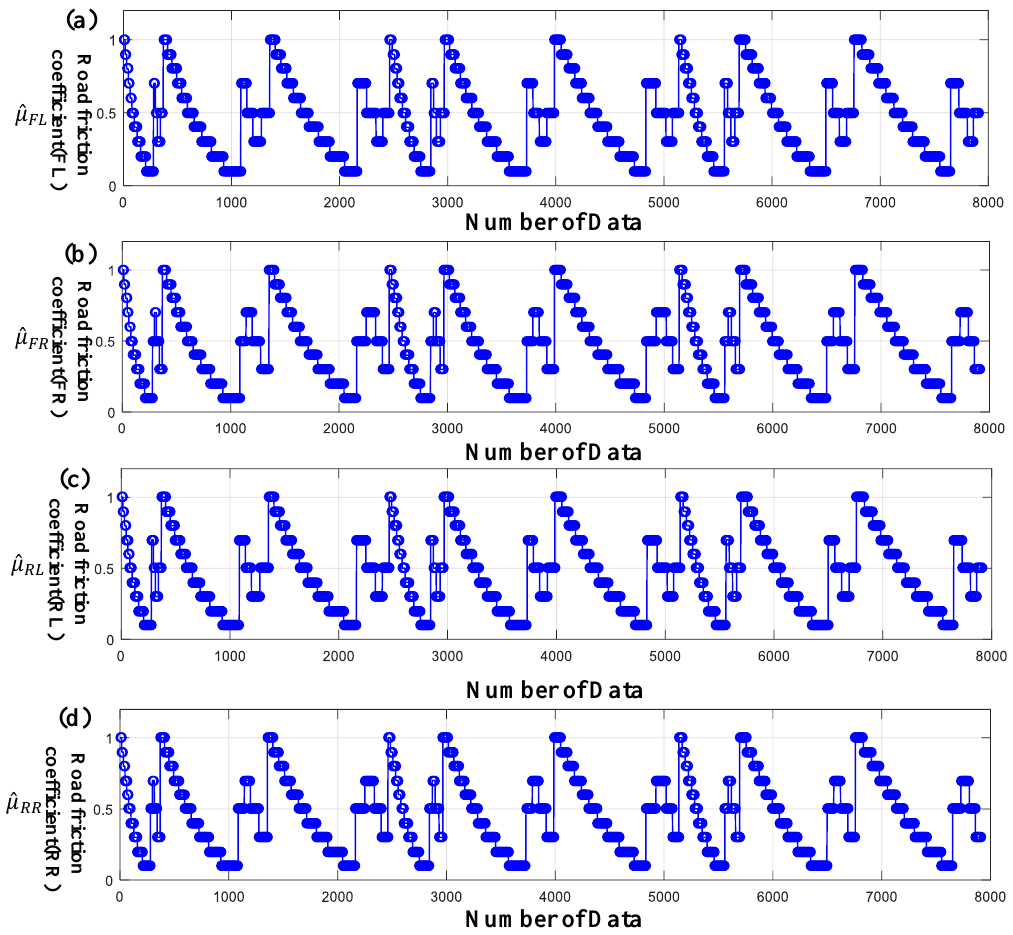
Figure 9. True references for training data (road friction coefficients). ( a ) Front left wheel (FL), ( b ) front right wheel (FR), ( c ) rear left wheel (RL), and ( d ) rear right wheel (RR).